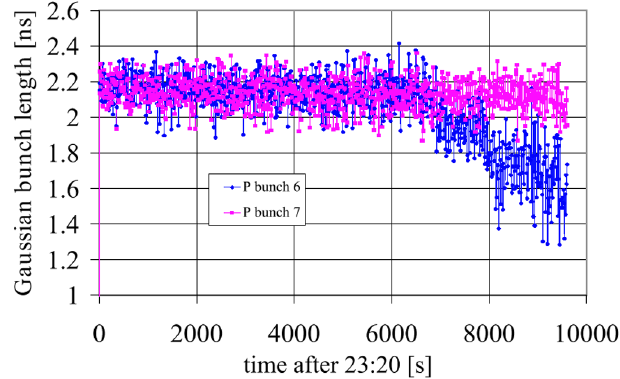
FIG. 87. (Color) Bunch length from a Gaussian fit to wall- current monitor signal as a function of time for proton bunches P6 and P7; bunch P6, which interacts with the TEL, is shaved longitudinally [99].